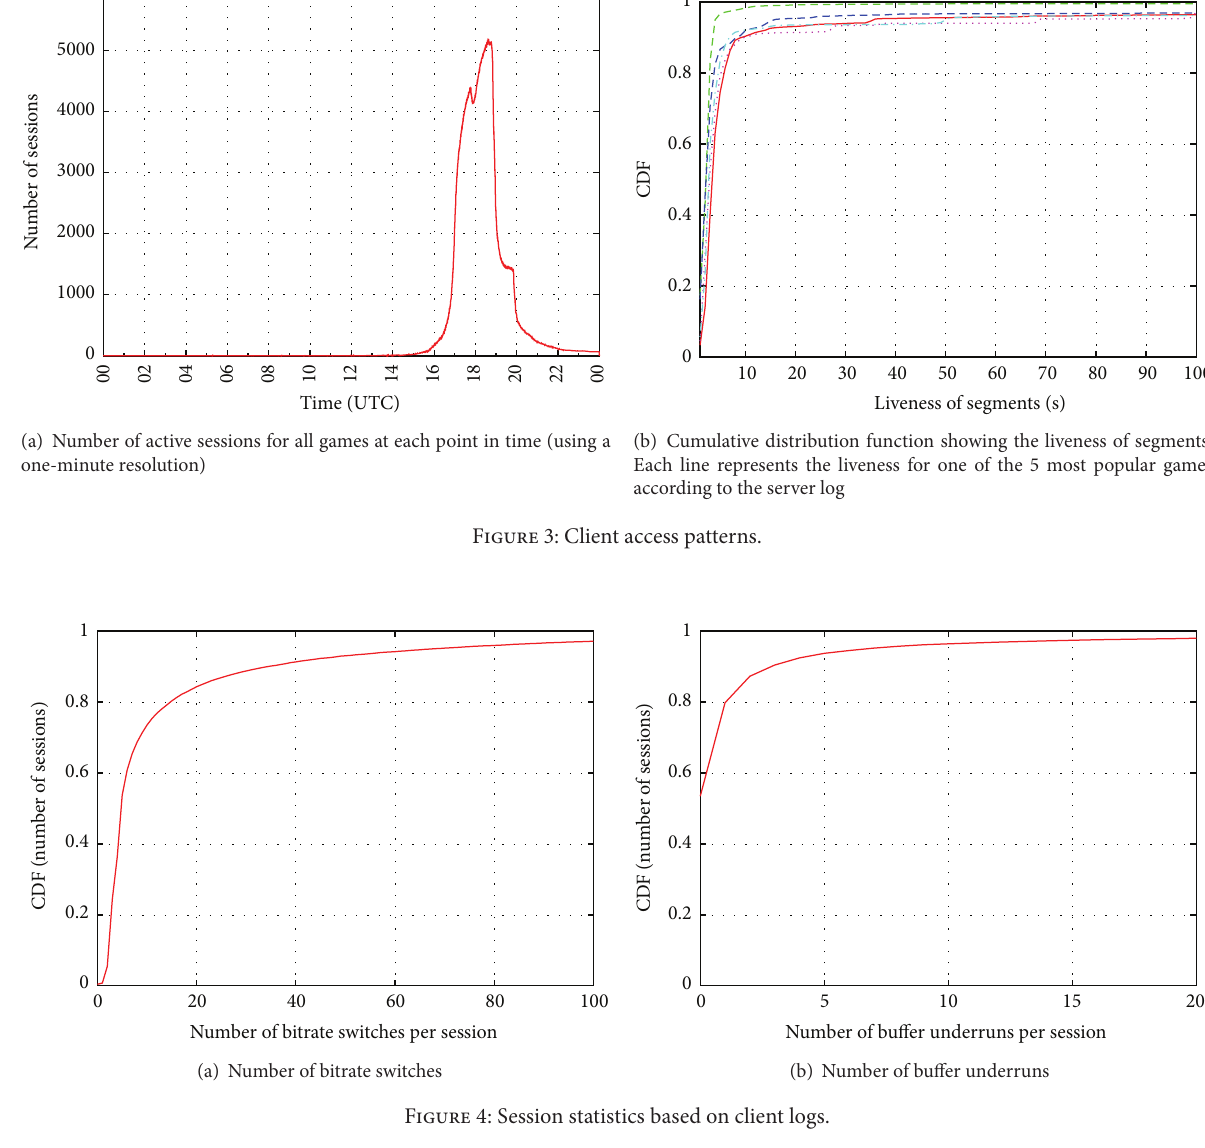
Figure 4: Session statistics based on client